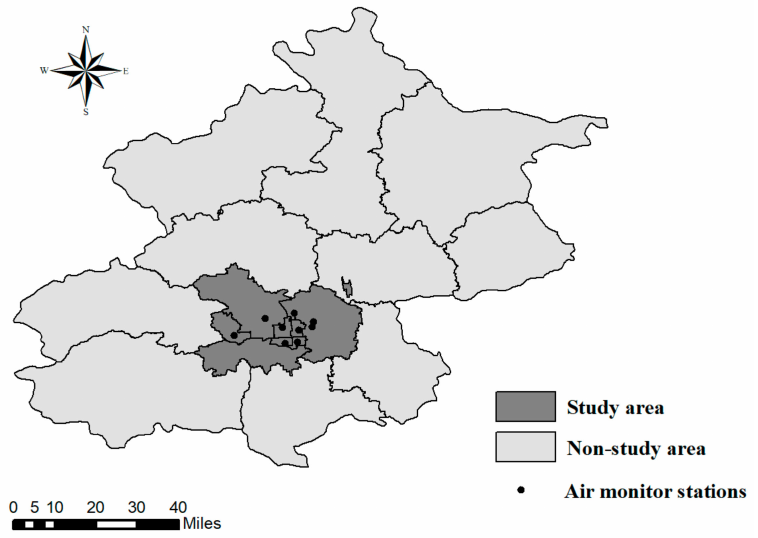
Figure 1. The location of air monitoring stations in the six urban districts of